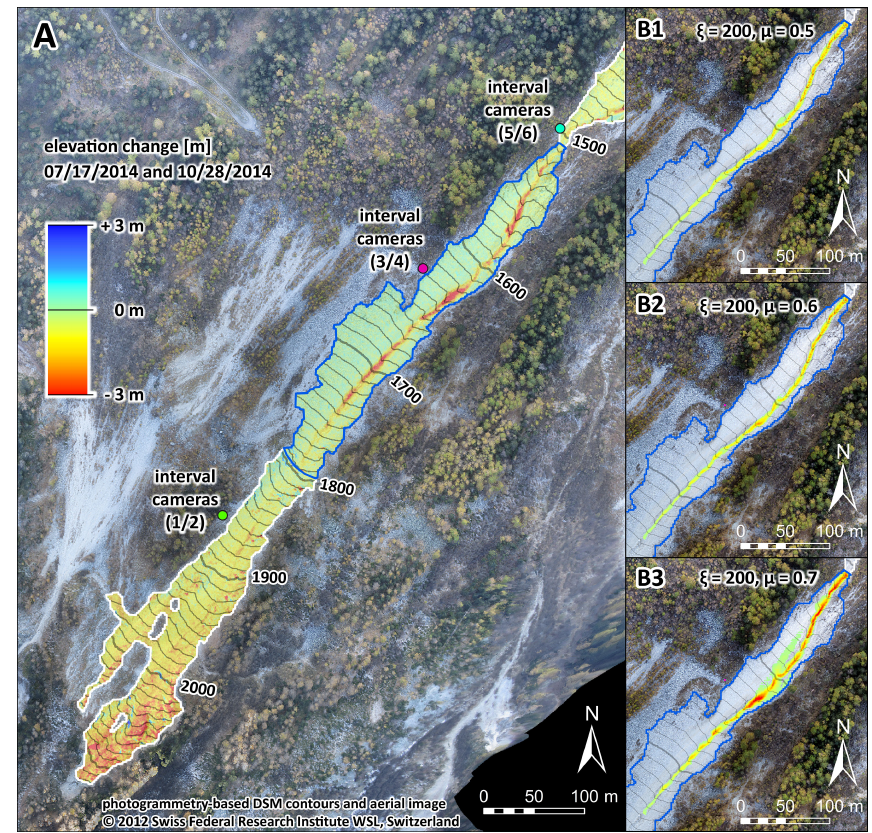
Figure 3. Calibration of modelled erosion patterns ( b1 to b3 ) to the observed erosion depths ( a ) in the upper open debris slopes of the “Bochtür” catchment (Meretschibach) by varying values for the friction parameter µ . The blue polygon demarks the area where a differential DTM is